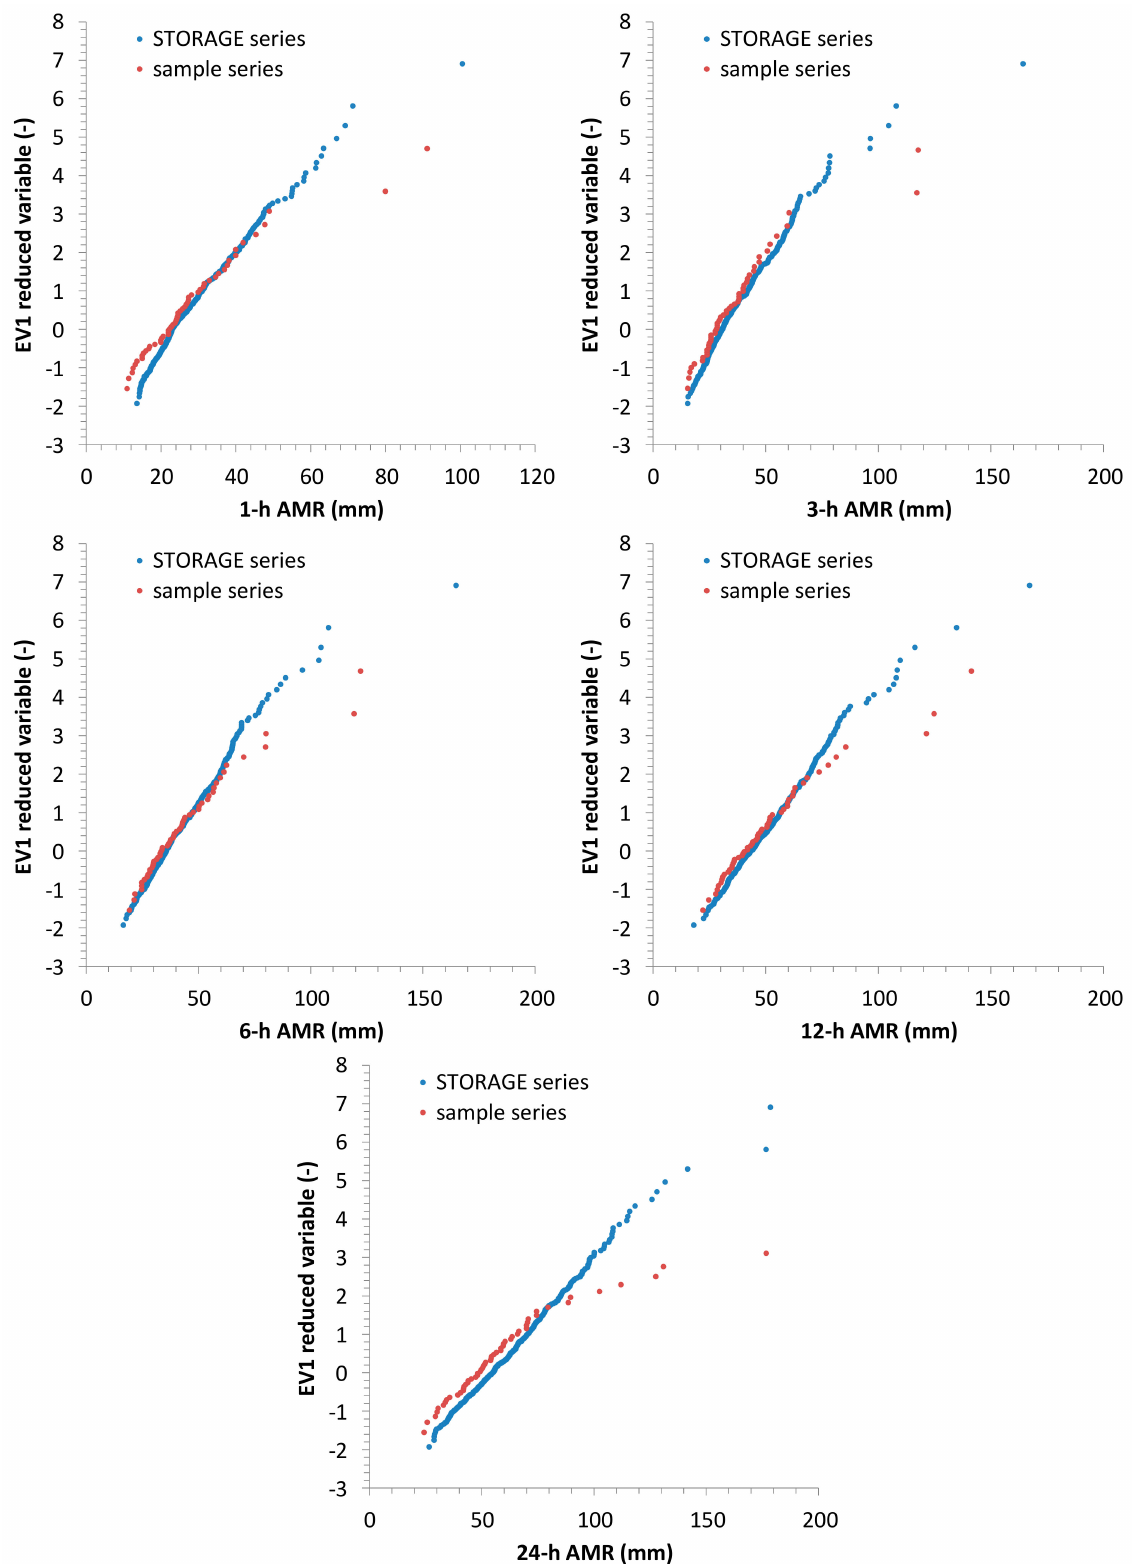
Figure 18. Reggio Calabria rain gauge: EV1 probabilistic plots, showing the comparison among synthetic and observed AMR